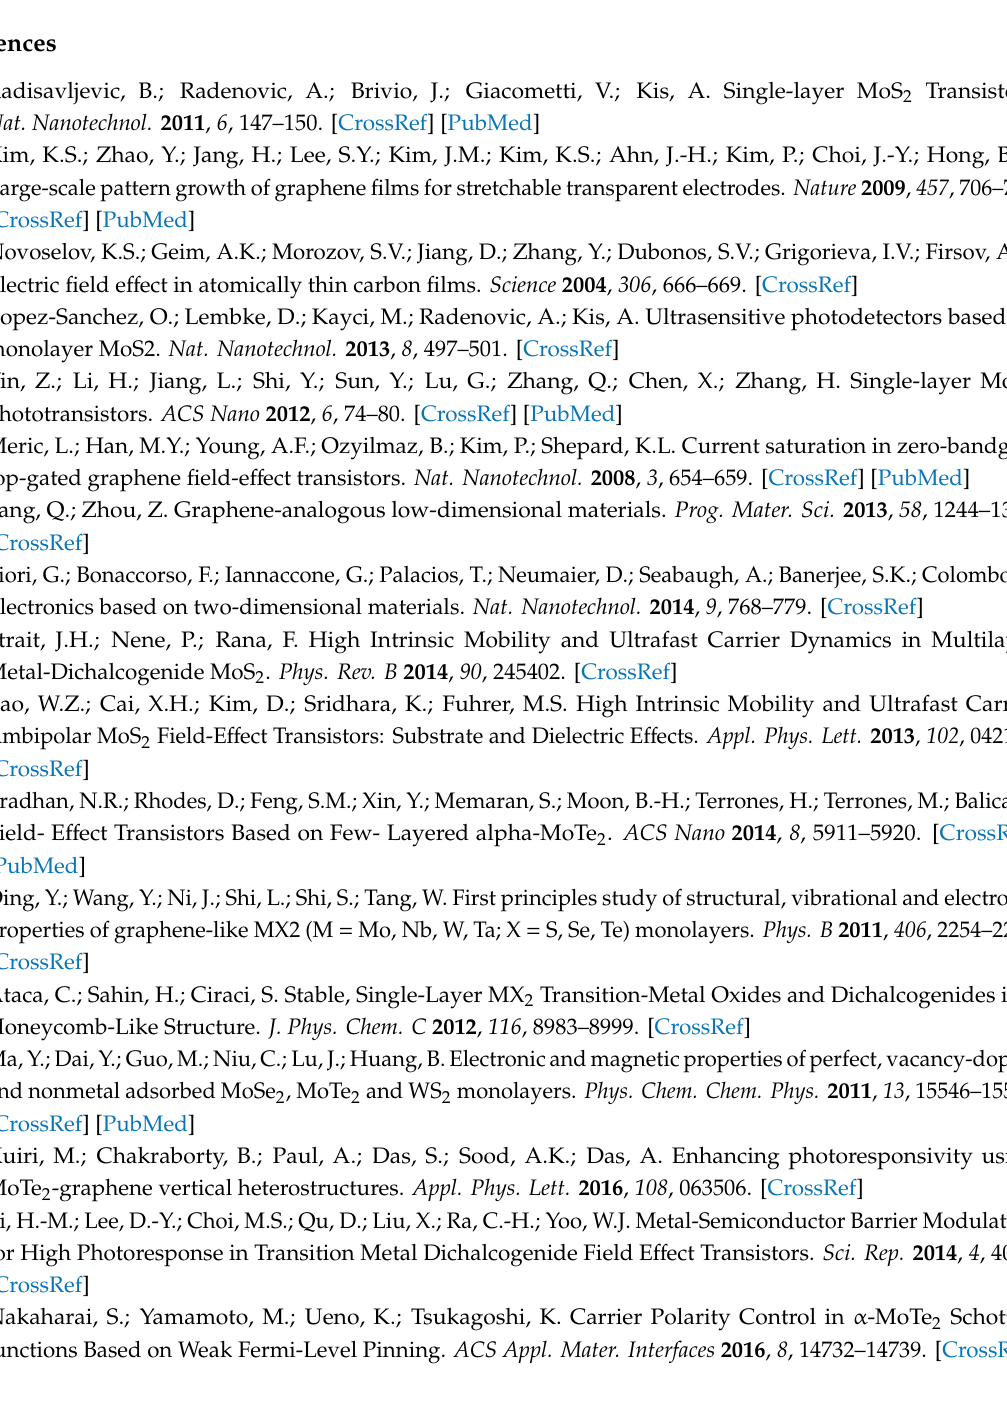
Figure S1, Process steps for plasma–assisted mechanical exfoliation; Figure S2, Process steps showing fabrication of source / drain contacts on exfoliated samples; Figure S3, Transient curve (current-time) of (a) 60 nm and (b) 6.1 nm MoTe 2 flakes for NH 3